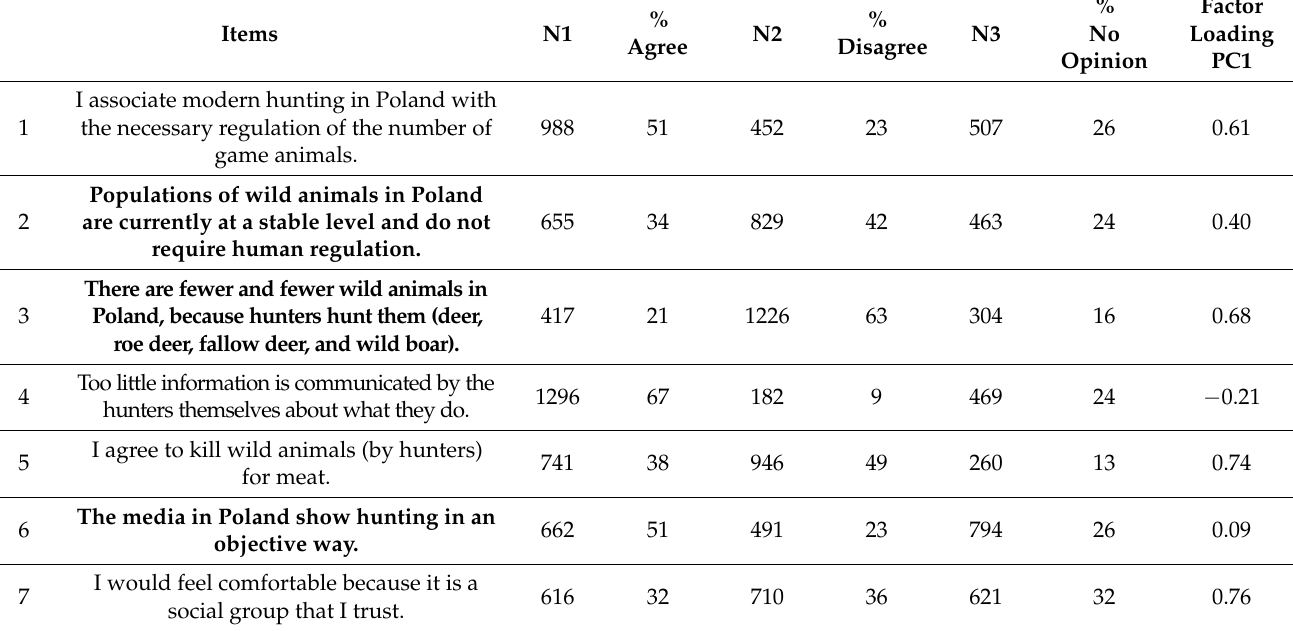
Table 1. Opinions of young Polish respondents about seven items related to attitudes regarding hunting and hunters. Loadings (from Principal Component Analysis) of each item on principal component one (PC1) are also shown. Questions in bold specifically investigated negative attitudes regarding hunting and hunters (thus “I agree completely”, “agree somewhat”, “disagree somewhat”, and “disagree completely” were awarded − 2, − 1, 1, and 2 points, respectively). Data were collected in 2020 from a random sample of 1947 Polish high school